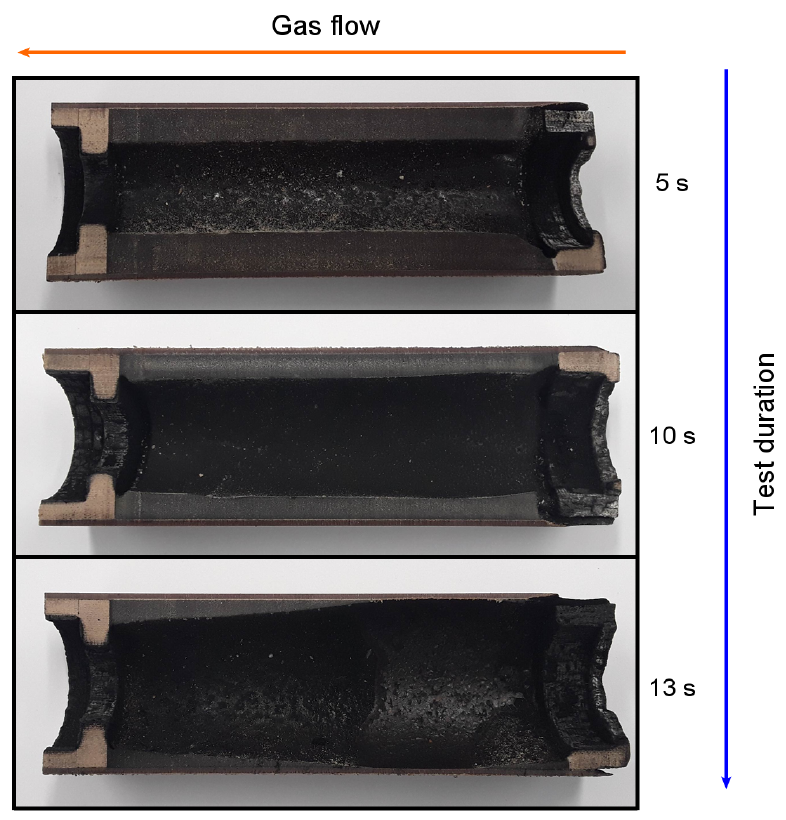
Figure 13. Sectional view of the Monoport fuel blocks after different test